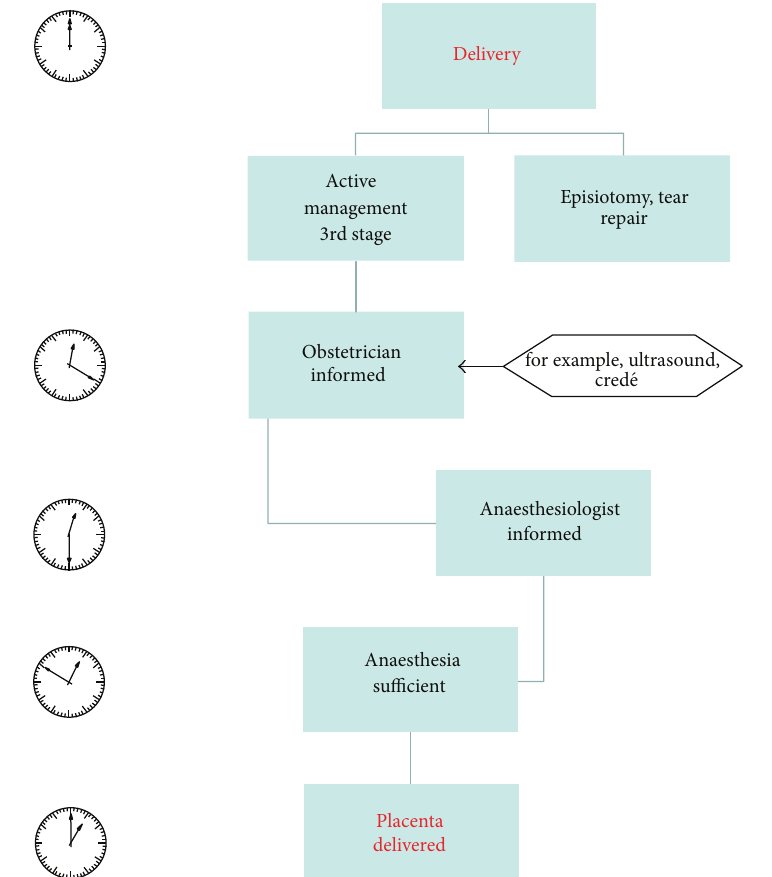
Figure 1: Flowchart for the treatment of retained placenta with special emphasis on the time